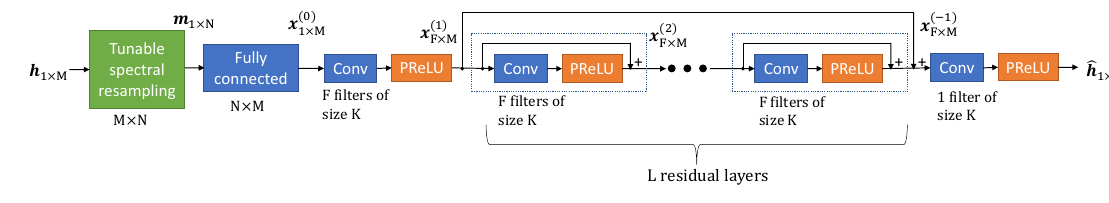
Figure 2. Proposed network